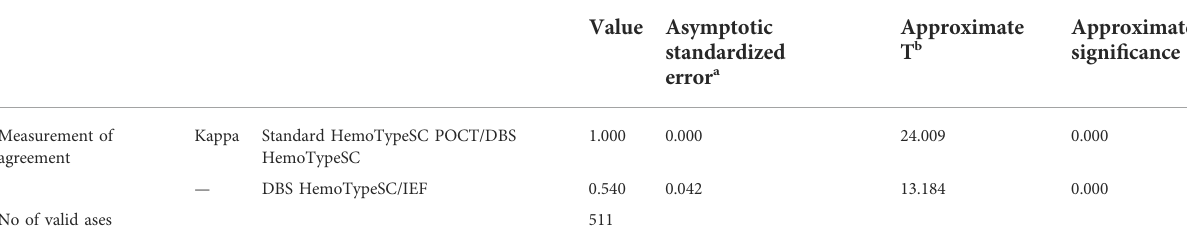
TABLE 5 Cohen ’ s Kappa Statistics showing the level of agreement of Kappa between DBS HemoTypeSC/Standard HemoTypeSC and DBS HemoTypeSC/IEF. Symmetric